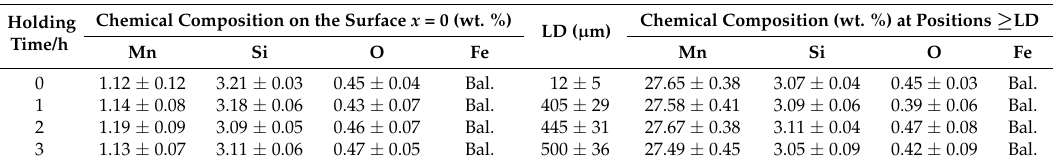
Table 1. The average chemical composition and Mn depletion region (LD) of the MM Fe-Mn-Si alloys sintered at 1200 °C for different isothermal holding times.